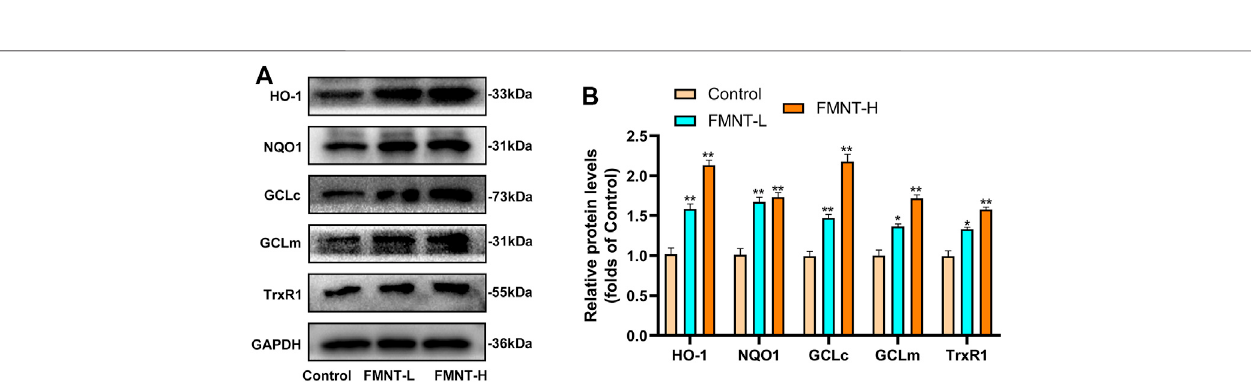
FIGURE 5 | (A) The protein expression of Nrf2, LaminB and Keap1 was detected by western blot (B) The Nrf2/Lamin B1 ratio and the Keap1/GADPH ratio was determined. All data represent mean ± SD. ** p ≤ 0.01 compared to the control group.